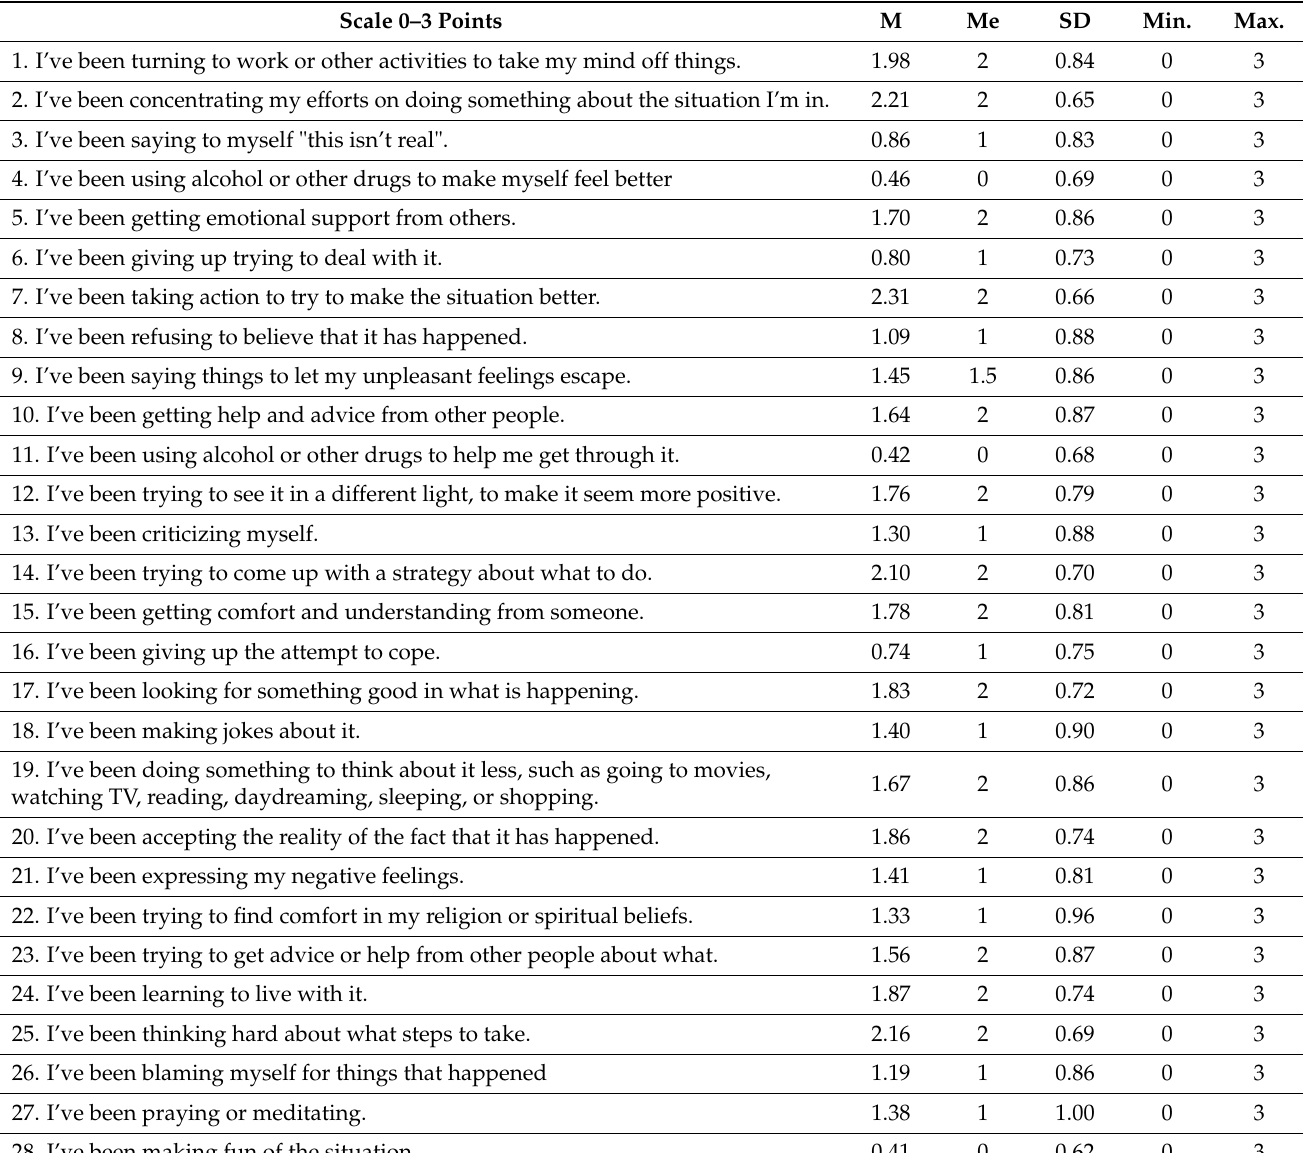
Table 2. Strategies for coping with difficult situations (Mini-COPE)—the results of individual items. Scale 0–3